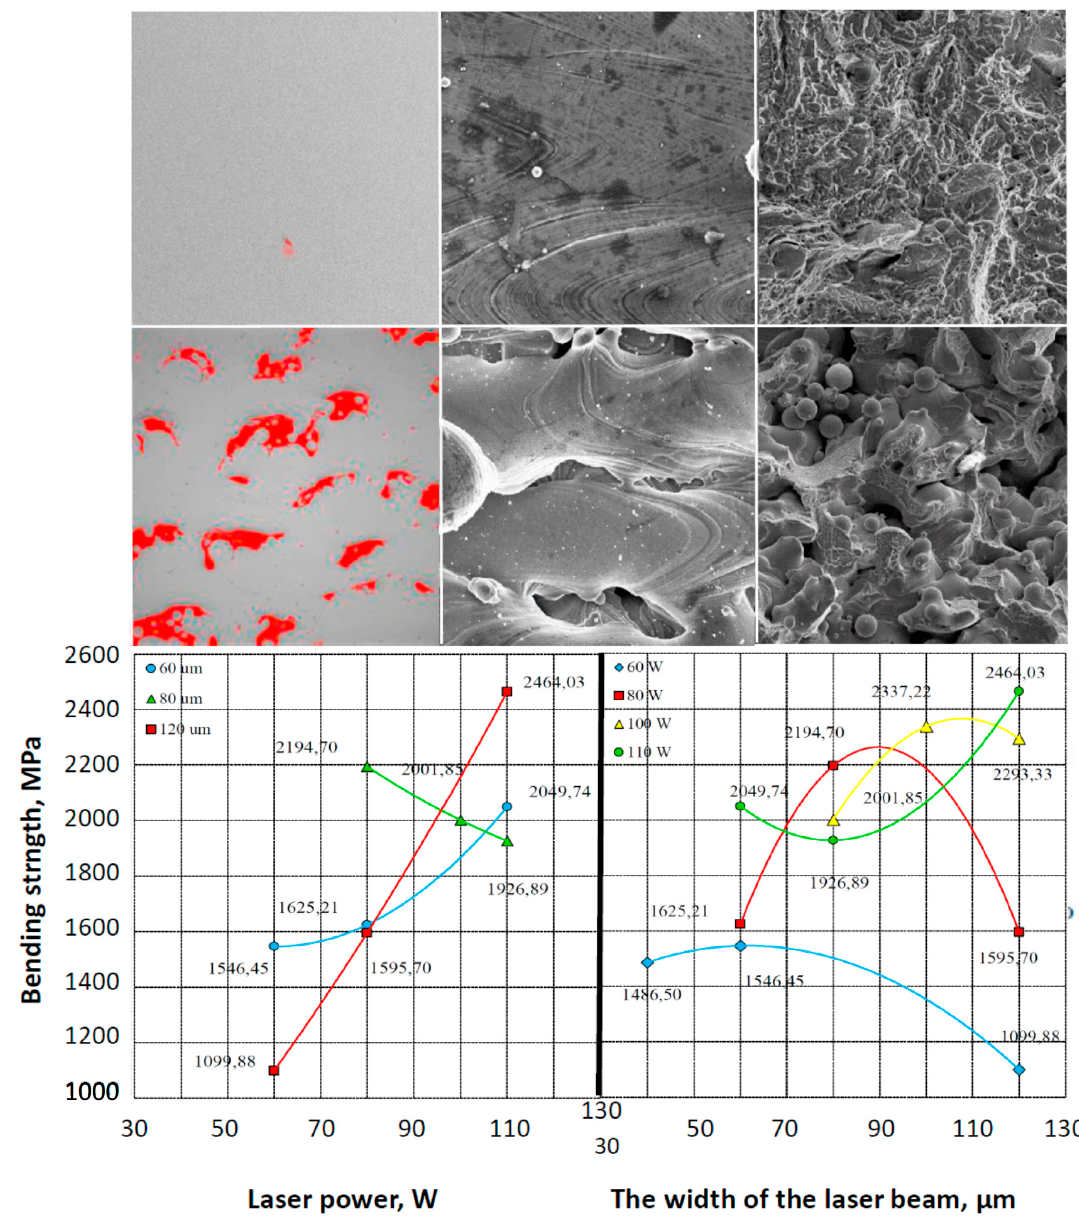
Figure 21. Influence of laser power and laser spot width on the bending strength and structure of a selectively laser-sintered Ti6Al4V alloy; the top-row of photos the structure of this material produced by the SLS method in appropriately selected conditions, guaranteeing a bending strength of approx. 2464 MPa; the middle-row of photos the structure of material ensuring the strength of only approx. 1099 MPa; the bottom-row with diagrams - the e ff ect of the laser power (first) and the width of the laser spot (second) on the bending strength; first column of photos the illustration in red of the pores at a magnification of 100 × , in the first-row with a pore area fraction of 0.03% and in the second-row a fraction of 10.53%; in both cases, the width of the laser dot is 120 µ m, while the laser power is 110 and 60 W, respectively; the presence of these pores in the second case in the second column at the bottom is visualized in a scanning electron microscope; the third column—the fractures of the tested specimens after bending—in the first-row fracture with a homogeneous structure, without pores and visible boundaries of the sintered powder particles; in the second-row, the structure of the fracture heterogeneous, with visible fragments where there are open pores and spherical particles, completely or partially unsintered